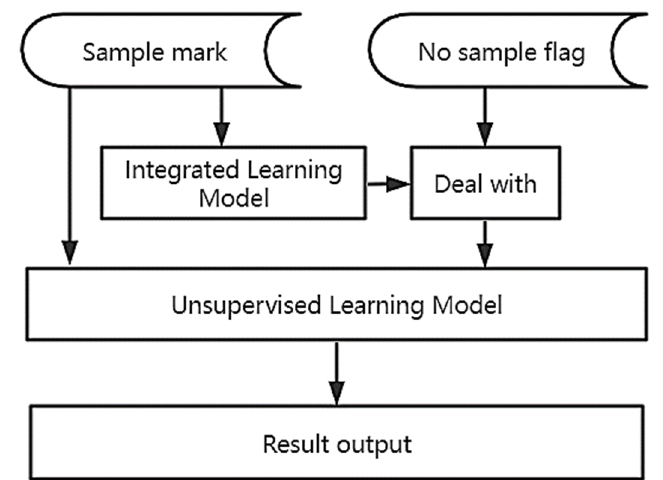
Figure 8. Ensemble-based semi-supervised learning.